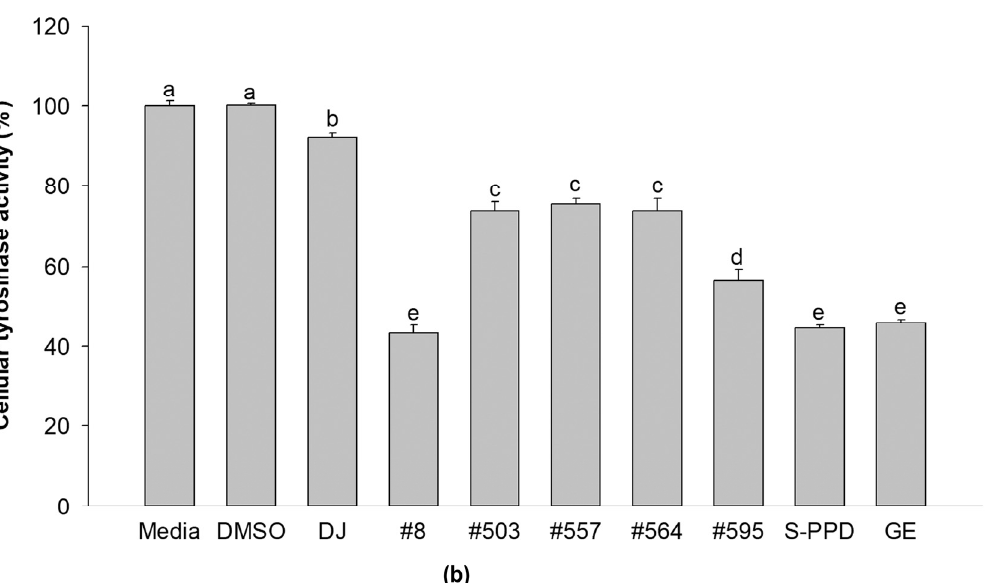
Figure 4. Effects of the PPD-enriched transgenic rice seed extracts on cellular tyrosinase activity. ( a ) L-DOPA staining in melan-a cells and ( b ) cellular tyrosinase activity. DJ, #8, #503, #557, #564, and #595 concentrations were 100 µg/mL. DMSO, S-PPD, and GE concentrations were 0.1%, 700 pg/mL, and 100 µg/mL, respectively. Data are shown as mean ± standard deviation ( n = 3). Lowercase letters indicate significant differences at p < 0.05 among the treatments.